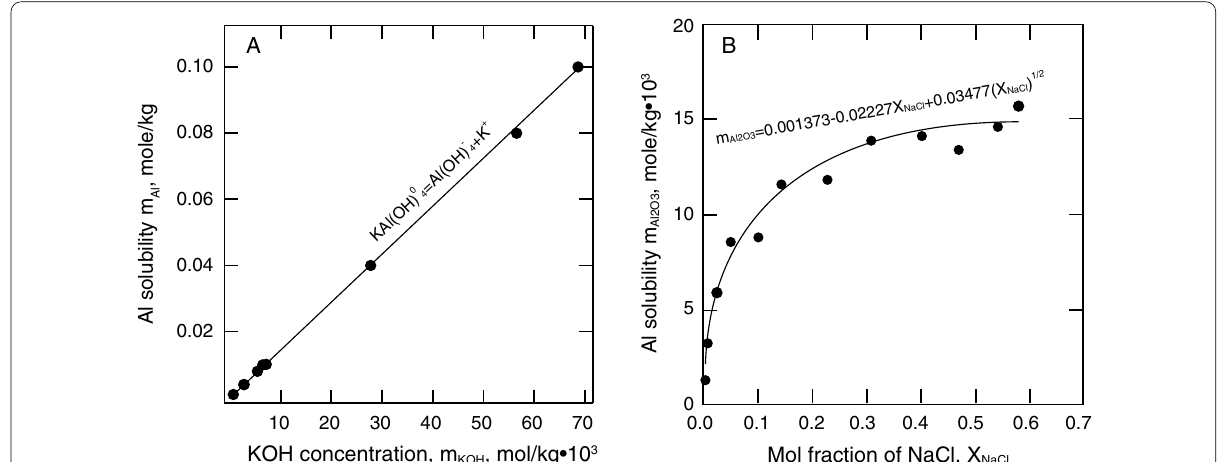
Fig. 19 A . Aluminum solubility in alkaline fluid, m Al , as a function of KOH concentration in the Al 2 O 3 –H 2 O–KOH system at 50–200 MPa pressure and 400 °C. B . Aluminum solubility in H 2 O–NaCl fluid as a function of NaCl concentration in the system Al 2 O 3 –H 2 O–NaCl at 800 °C and 1 GPa. Modified from Azaroual et al. (1996) (A) and Newton and Manning 2006